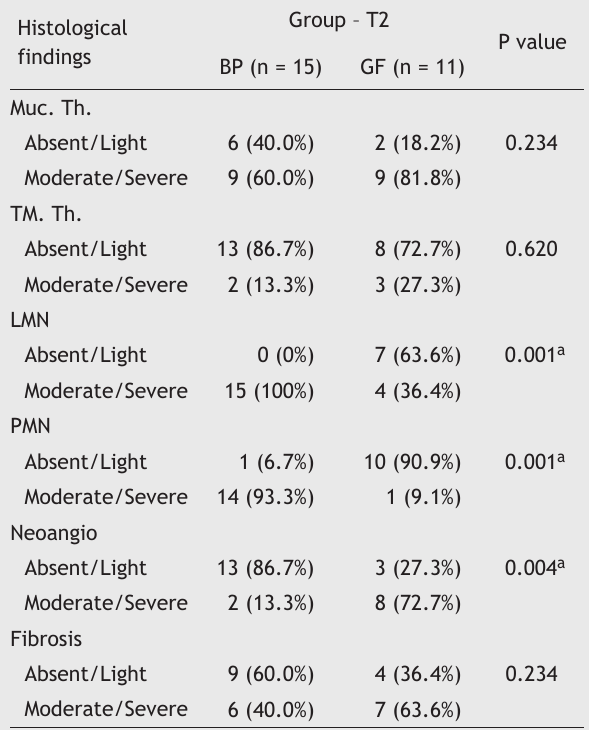
Table 3 Comparison between groups of biomaterials in re- lation to histological findings in the tympanic bulla of rats after 1 month of experiment (T1).